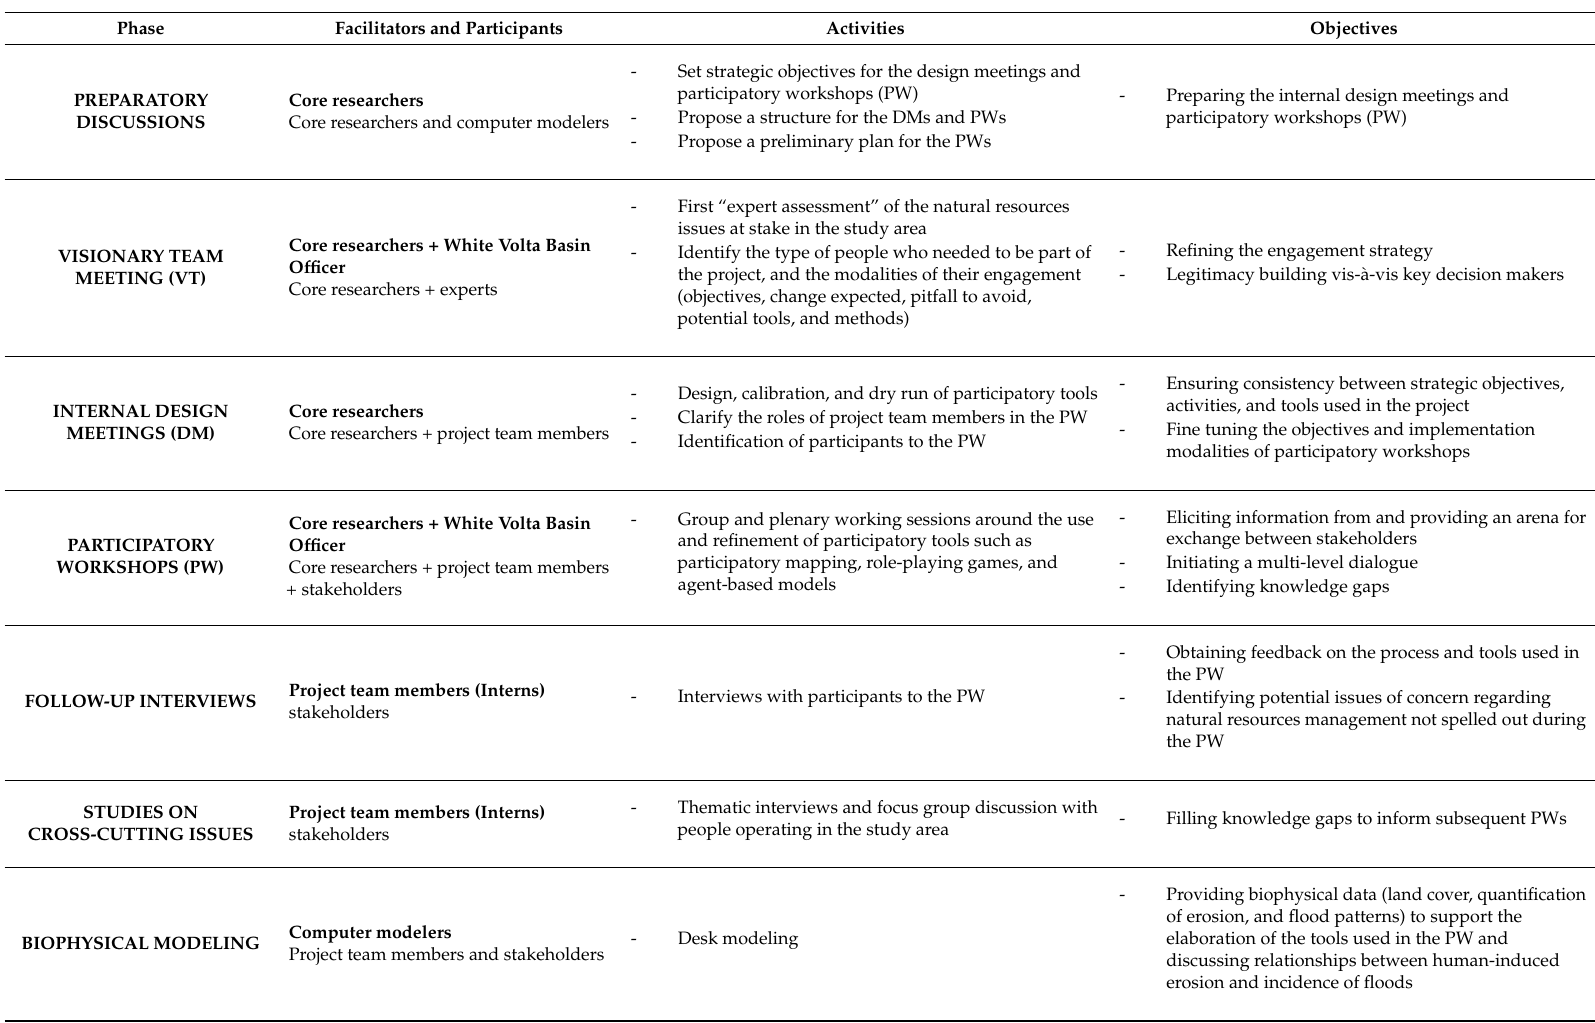
Table 1. Main characteristics of the activities performed during the participatory